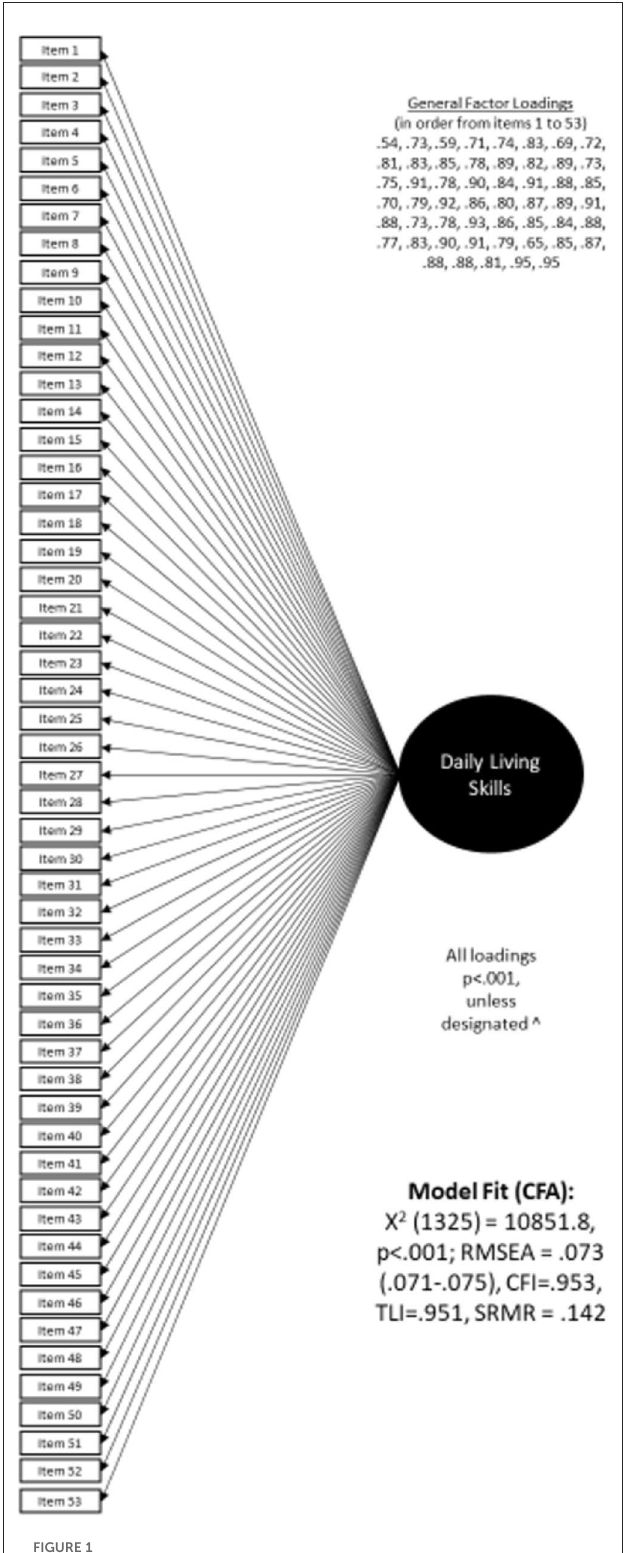
FIGURE1 Single factor CFA model in the total validation sample.